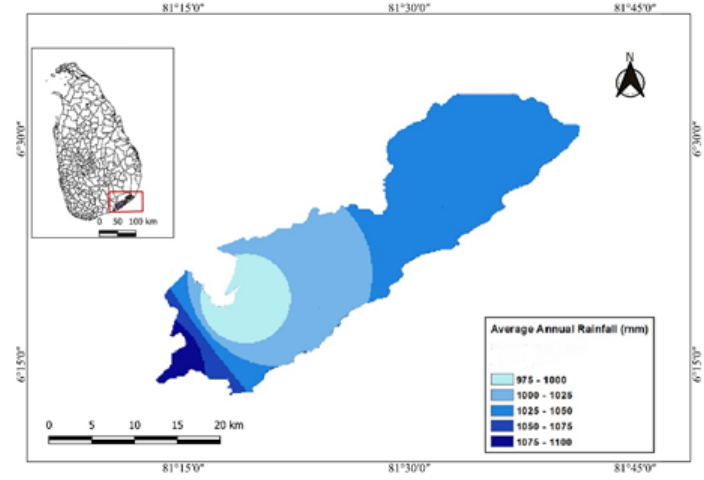
Figure 5. Average annual rainfall map of Tissamaharama DSD.